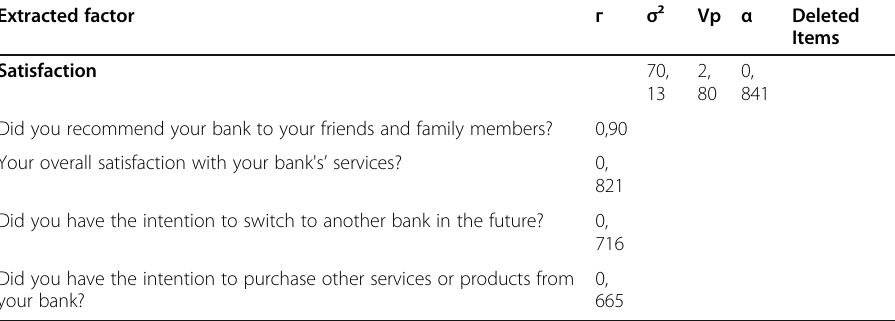
Table 6 Factors, factor loadings, and reliabilities for satisfaction construct Extracted factor